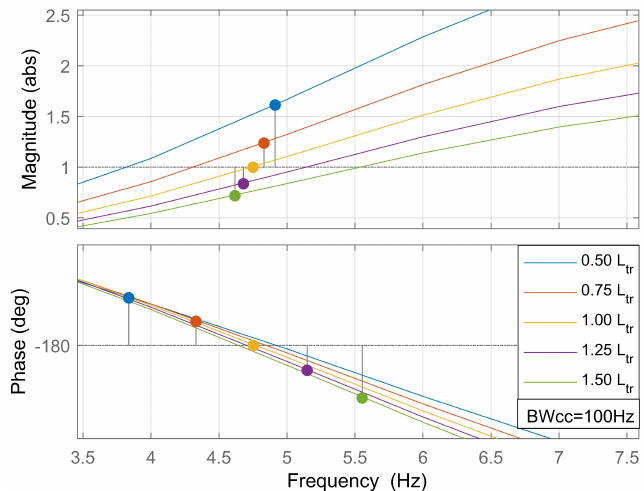
Figure 14. Bode diagram of the system eigenvalue λ 1 . Variation of leakage inductance while the keeping current controller bandwidth at 100 Hz.